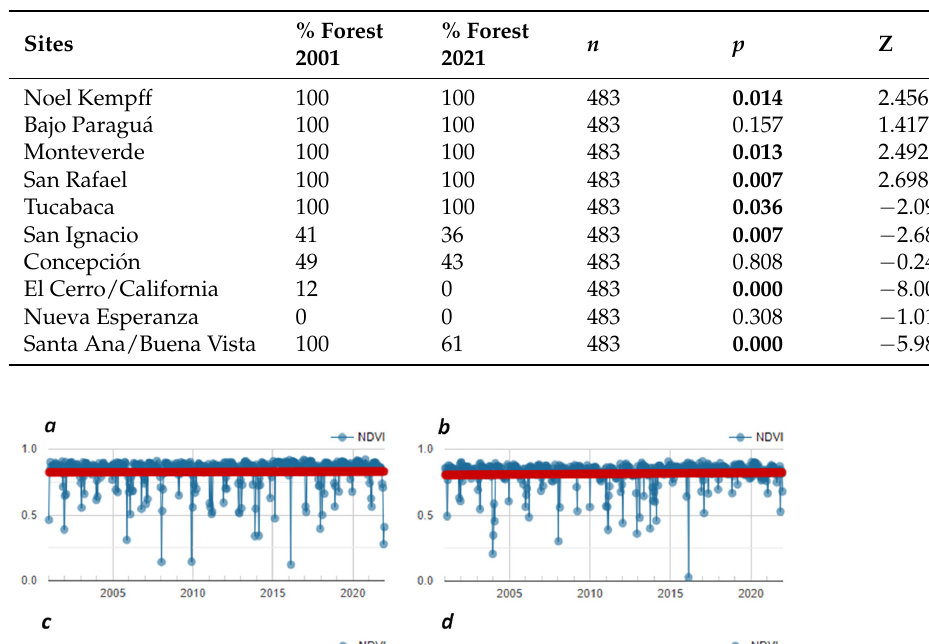
Table 2. Trends in NDVI time series in forested and deforested areas in the Chiquitania region (2001–2021). n —MODIS data series, p —statistical significance < 0.05 (highlighted in bold), Z—Mann– Kendall nonparametric test.